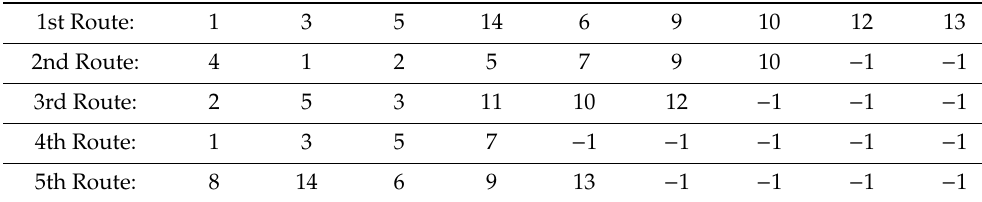
Table 2. The route set representation